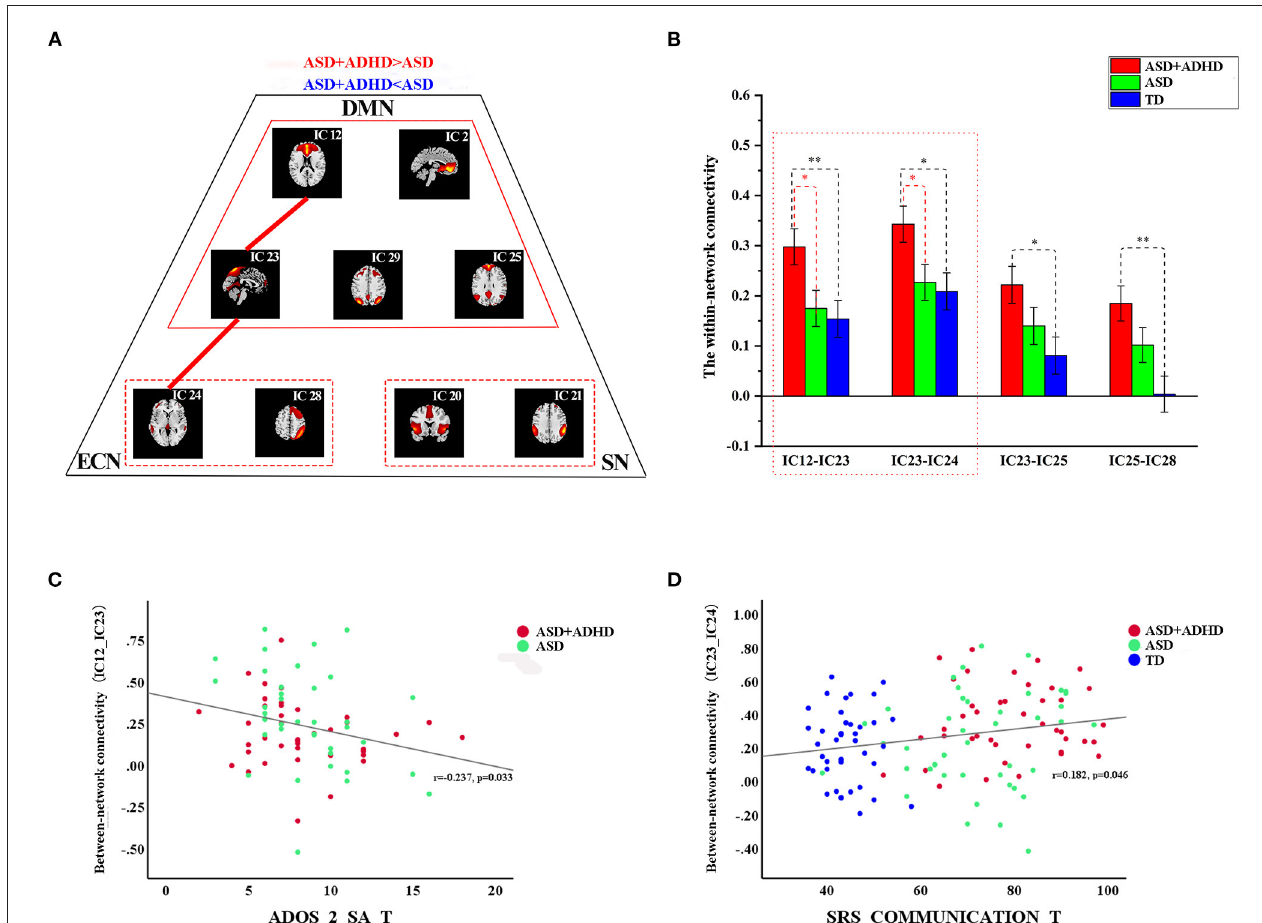
FIGURE 3 | Differences in between-network connectivity and the correlations of clinical measures with abnormal connectivity (A) The red line indicates increased FNC strength in ASD + ADHD and the blue line displays the reverse situation. Further details are shown in Table 3 . (B) Extracted altered between-network connectivity, ASD + ADHD group showed increased dDMN (IC 12)–vDMN (IC 23) connectivity and LECN (IC 24)–vDMN (IC 23) connectivity. (C) The altered dDMN (IC 12)–vDMN (IC 23) between-network connectivity by ADOS_2_SA scores. (D) The altered dDMN (IC 12)–vDMN (IC 23) between-network connectivity by SRS_communication